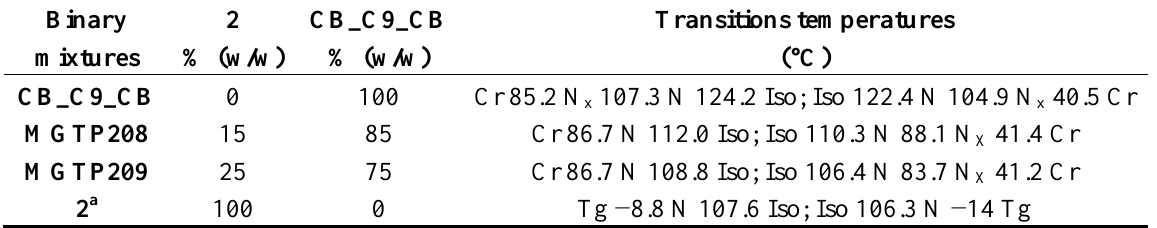
Table 2. Transition temperatures of the binary mixtures (w/w) of 2 with the dimer,